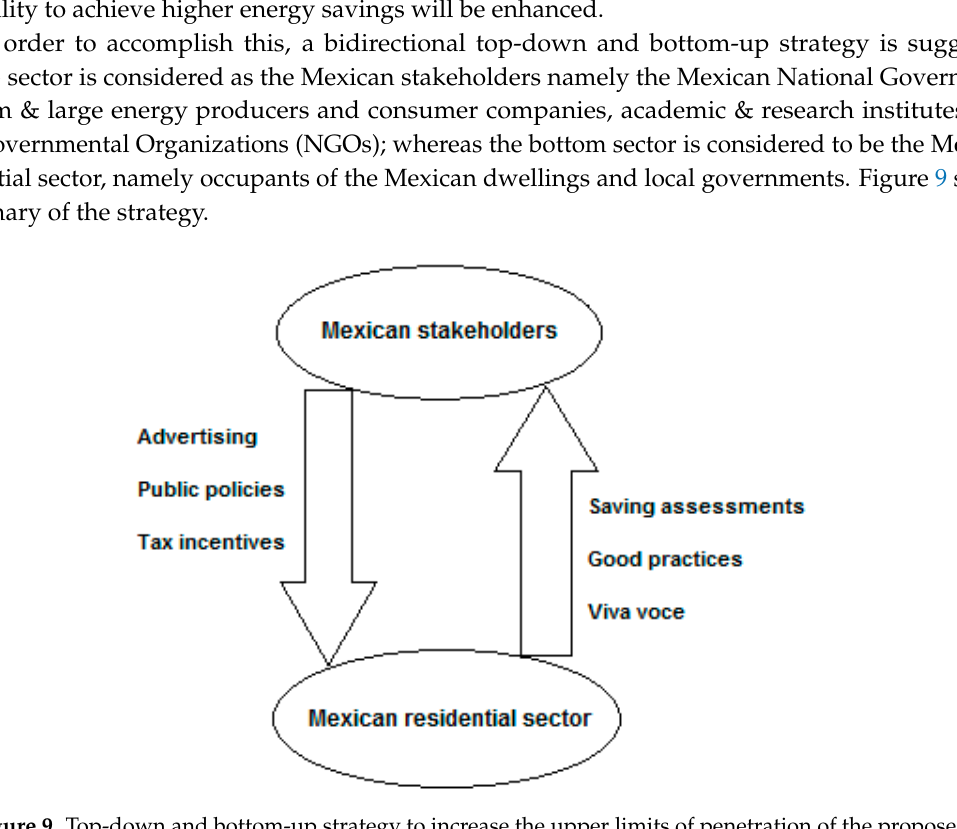
Figure 9. Top-down and bottom-up strategy to increase the upper limits of penetration of the proposed approaches of energy saving.